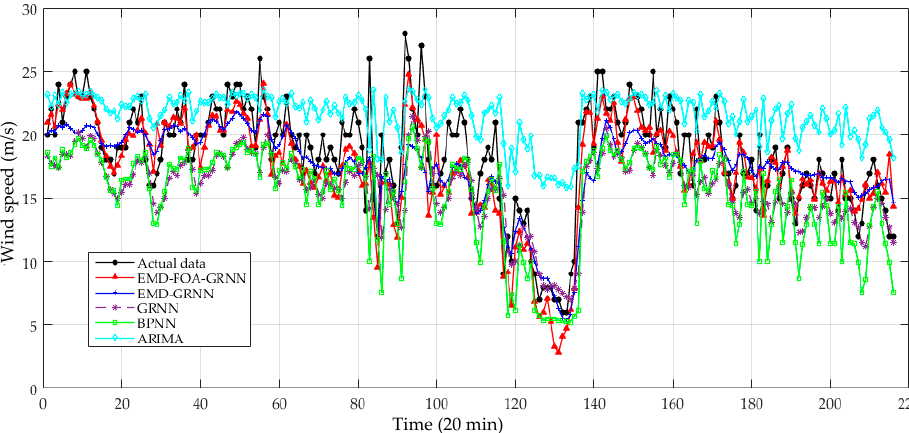
Figure 14. Prediction results of wind speed from 23 March 2012 to 25 March 2012 (III).